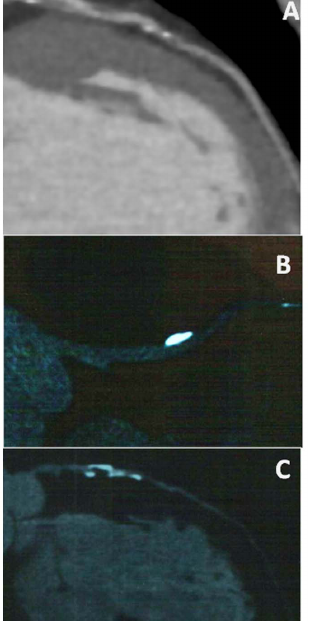
Figure 1. Coronary calcification was grouped as follows: spotty, length of calcium , 3/2 of the vessel diameter and width , 2/3 of the vessel diameter (A); medium, length of calcium $ 3/2 of the vessel diameter and width , 2/3 of the vessel diameter or length of calcium , 3/2 the vessel diameter and width $ 2/3 of the vessel diameter (B); and heavy, length of calcium burden $ 3/2 of the vessel diameter and width $ 2/3 of the vessel diameter